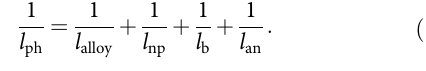
Fig. 3 Thermal current and contrast. a Cumulative current ( I / I tot ) in a beam of nonporous silicon (solid), compared with Si 90 Ge 10 with nanoparticles optomechanical crystal (dashed), as a function of phonon frequency at Θ 0 = 4 K (blue) and Θ = 0.4 K (purple) for a small temperature bias Δ Θ / Θ 0 0 = 10 − 3 . b Contrast C , de fi ned in Eq. (12), as a function temperature bias Δ Θ for an optomechanical cavity array made of Si 90 Ge 10 with 10 nm nanoparticles at Θ 0 = 0.4 K (purple), and 4 K (blue). We observe that the contrast increases as the temperature is decreased, because the optomechanically coupled phonons have a more pronounced role in